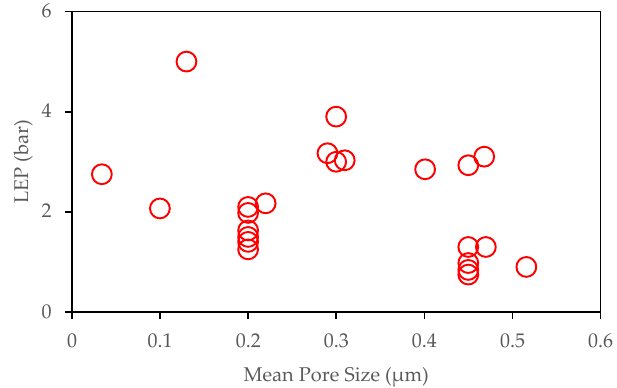
Figure 4. Summary of LEP over mean pore sizes (data obtained from references [43,45,48,52,115–123]).